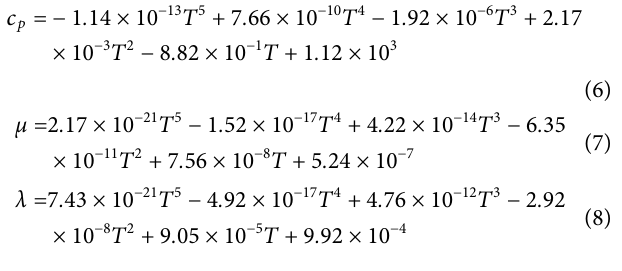
transport properties where speci fi c heat capacity at constant pressure is shown in Eq. 6 , molecular viscosity is shown in Eq. 7 , and thermal conductivity is shown in Eq. 8 .